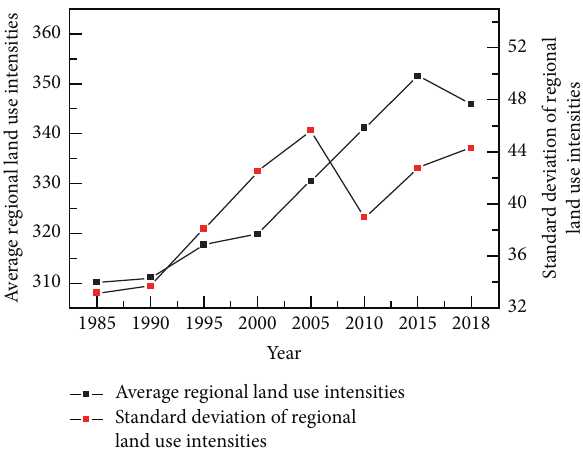
Figure 7: Statistics of land use intensities in the central urban area of the study